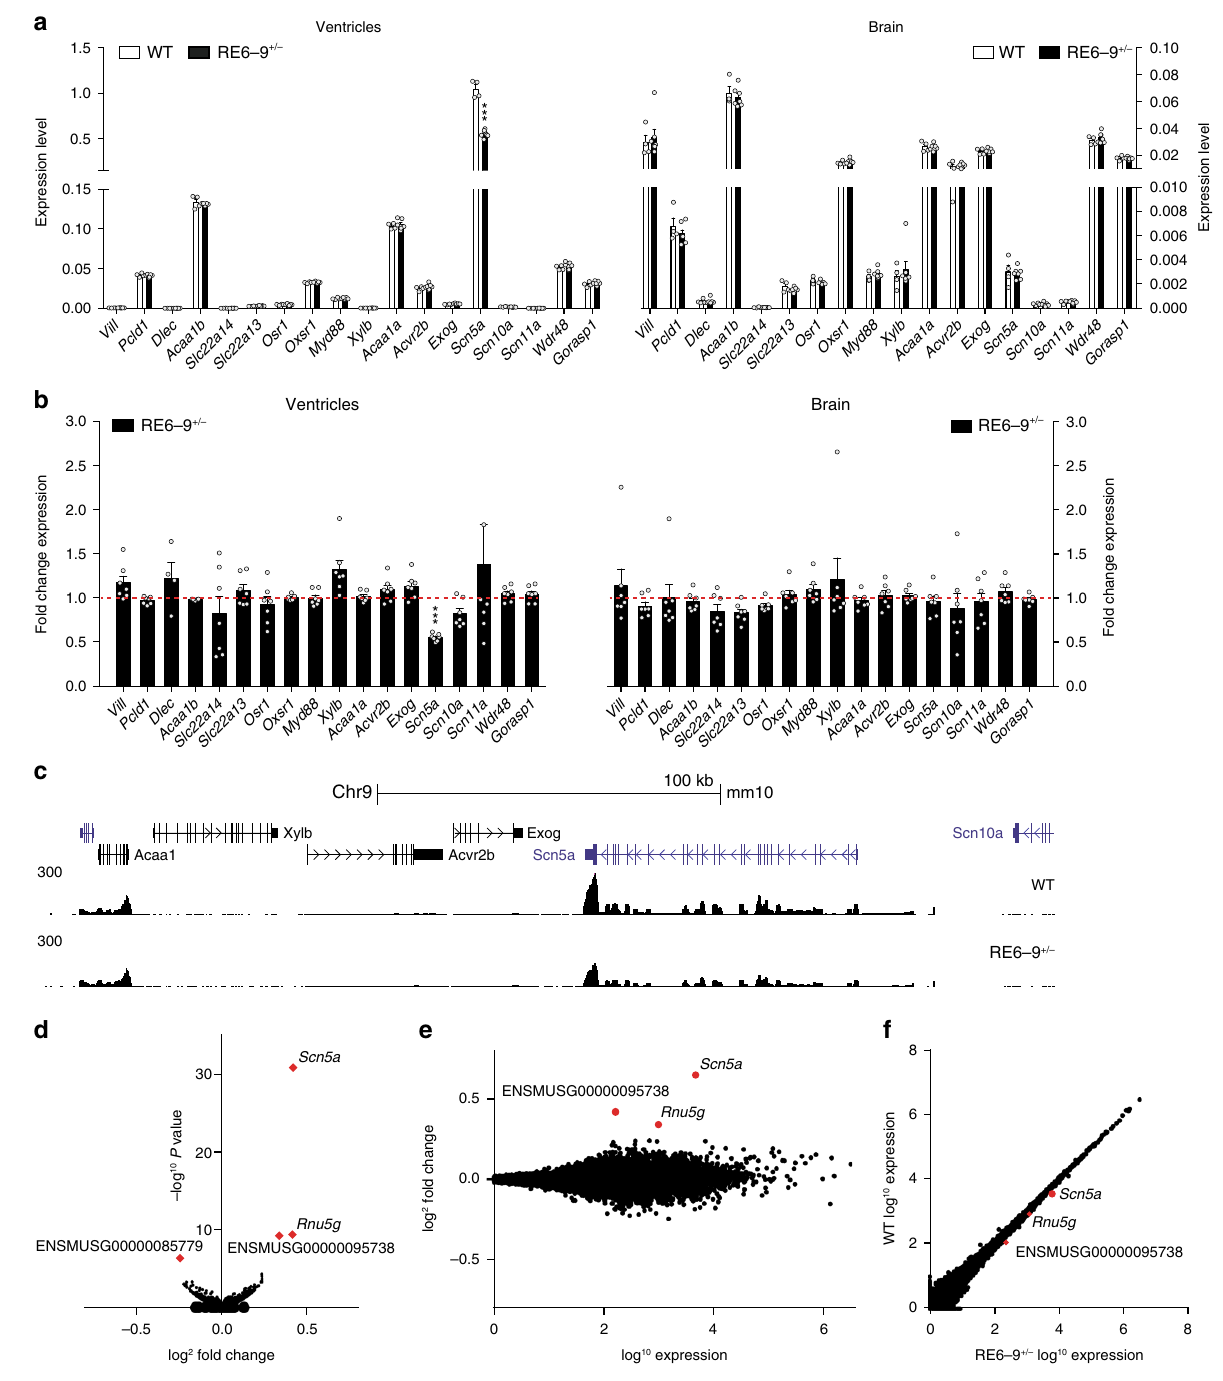
Fig. 4 Transcriptome analysis of heterozygous RE6-9 + / − mice. a , b Absolute expression ( a ) and fold change expression ( b ) levels of Scn5a , Scn10a and genes within and outside Scn5a TAD from ventricles (left) and brain (right) from 2-week old RE6-9 + / − mice compared to wiltype (WT). Bars represent mean ± SEM and P values were calculated using unpaired Student ’ s t test. WT n = 4; RE6-9 + / − n = 7. *** P < 0.001. c UCSC browser view of the Scn5a- Scn10a locus showing RNA-seq pro fi le of WT and RE6-9 + / − mice. d – f Vulcano plot ( d ), MA plot ( e ) and scatter plot ( f ) of approximately 15.000 transcripts showing only Scn5a is highly signi fi cantly ( P = 3.75e-27) downregulated in RE6-9 + / − mice compared to WT. P values were corrected for multiple testing using the false discovery rate (FDR) method of Benjamini-Hochberg ( P < 0.05). Source data are provided as a Source Data fi